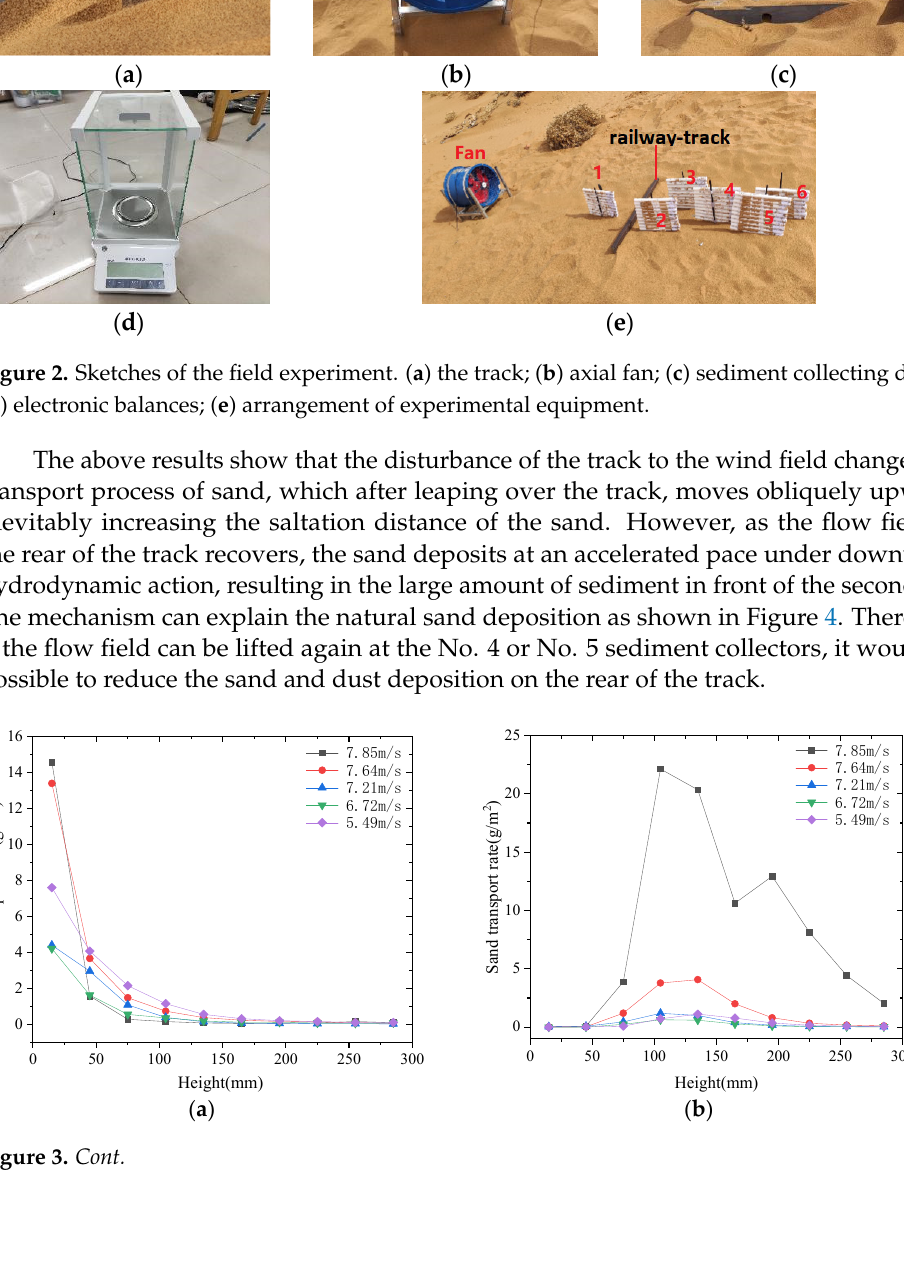
( f ) Figure 3. The sand transport rate of each sediment collecting device. ( a ) No. 1 sediment collecting device; ( b ) No. 2 sediment collecting device; ( c ) No. 3 sediment collecting device; ( d ) No. 4 sedi- ment collecting device; ( e ) No. 5 sediment collecting device; ( f ) No. 6 sediment collecting device. The above results show that the disturbance of the track to the wind field changes the transport process of sand, which after leaping over the track, moves obliquely upward, inevitably increasing the saltation distance of the sand. However, as the flow field in the rear of the track recovers, the sand deposits at an accelerated pace under downward hy- drodynamic action, resulting in the large amount of sediment in front of the second rail. The mechanism can explain the natural sand deposition as shown in Figure 4. Therefore, if the flow field can be lifted again at the No. 4 or No. 5 sediment collectors, it would be possible to reduce the sand and dust deposition on the rear of the track.